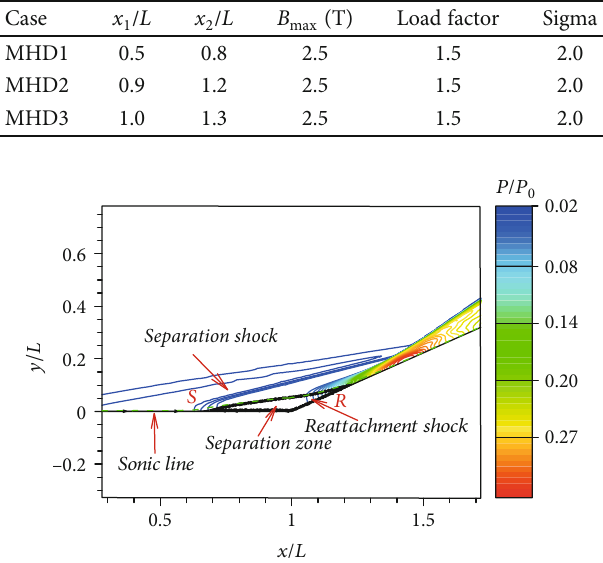
Figure 9: Flow fi eld structure induced by a ramp without MHD control.